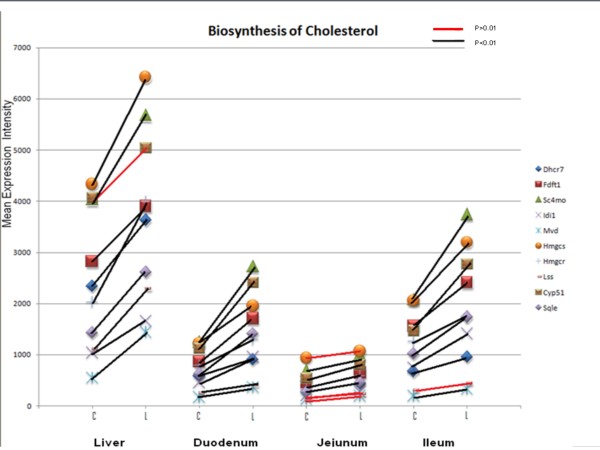
Plot of Mean Intensities for Known Cholesterol Biosynthetic Enzymes. The mean untransformed intensities were plotted against tissue/physiologic state combination. C and L indicate the mean of Control and Lactating samples, respectively, within each tissue. Abbreviations for genes are as follows. Dhcr7: 7-dehydrocholesterol reductase; Fdft1: farnesyl-diphosphate farnesyltransferase 1; Sc4mol: sterol-C4-methyl oxidase-like; Idi1: isopentenyl-diphosphate delta isomerase 1; Mvd: mevalonate (diphospho) decarboxylase; Hmgcs: 3-hydroxy-3-methylglutaryl-Coenzyme A synthase 1; Hmgcr: HMG Coenzyme A reductase; Lss: lanosterol synthase; Cyp51: cytochrome P450 family 51; Sqle: Squalene Epoxidase. A red line between Control and Lactating symbols for a given gene indicates p > .0.01 for the tissue pairwise comparison within the tissue from the mixed models repeated measures ANOVA on the log2 transformed intensities; the change was not considered significant for the purposes of determining a list of differentially expressed genes. A black line between C and L symbols indicates p < 0.01 as described above.